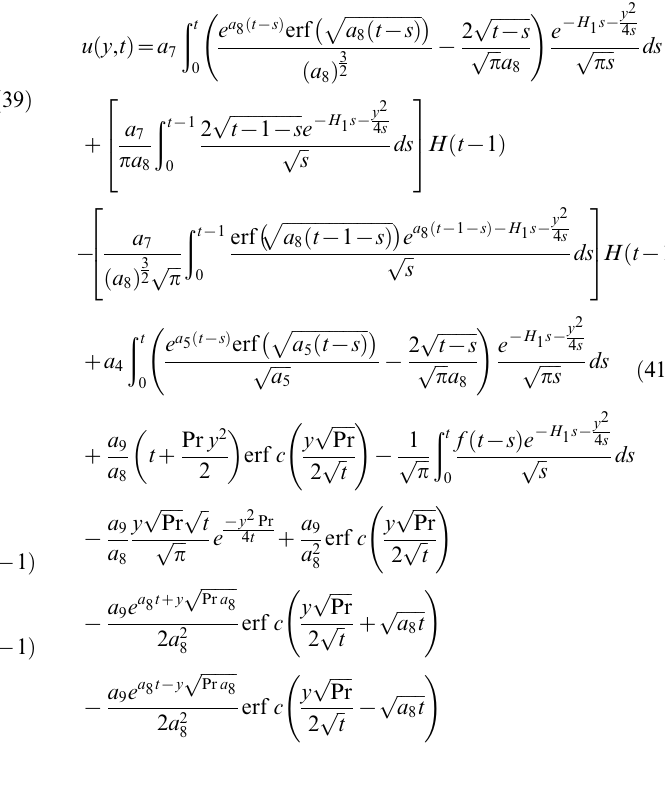
p 2 ffiffiffiffiffiffiffiffiffi t { s {